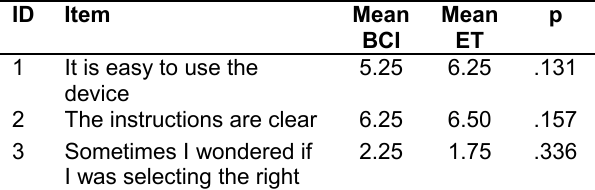
Table 1 . Average values of 7-point Likert scale